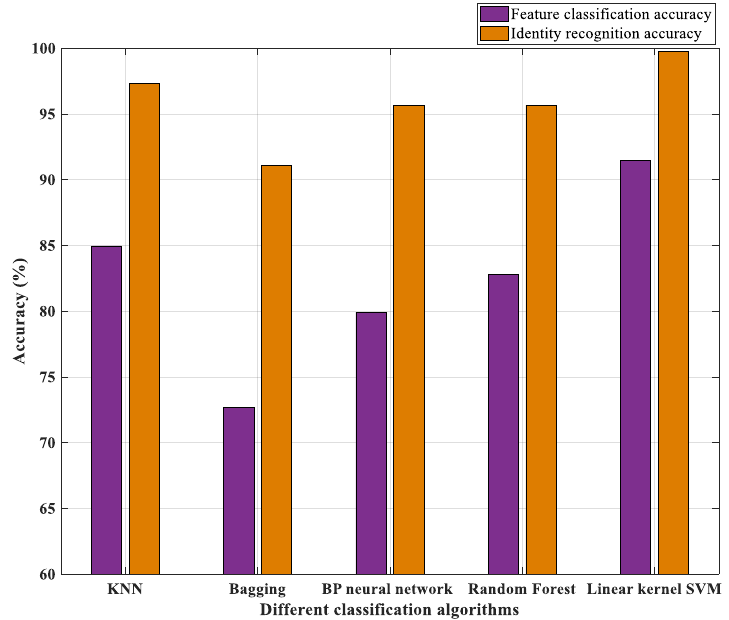
Figure 9. Comparison for recognition performance of different classifiers on mixed data set.